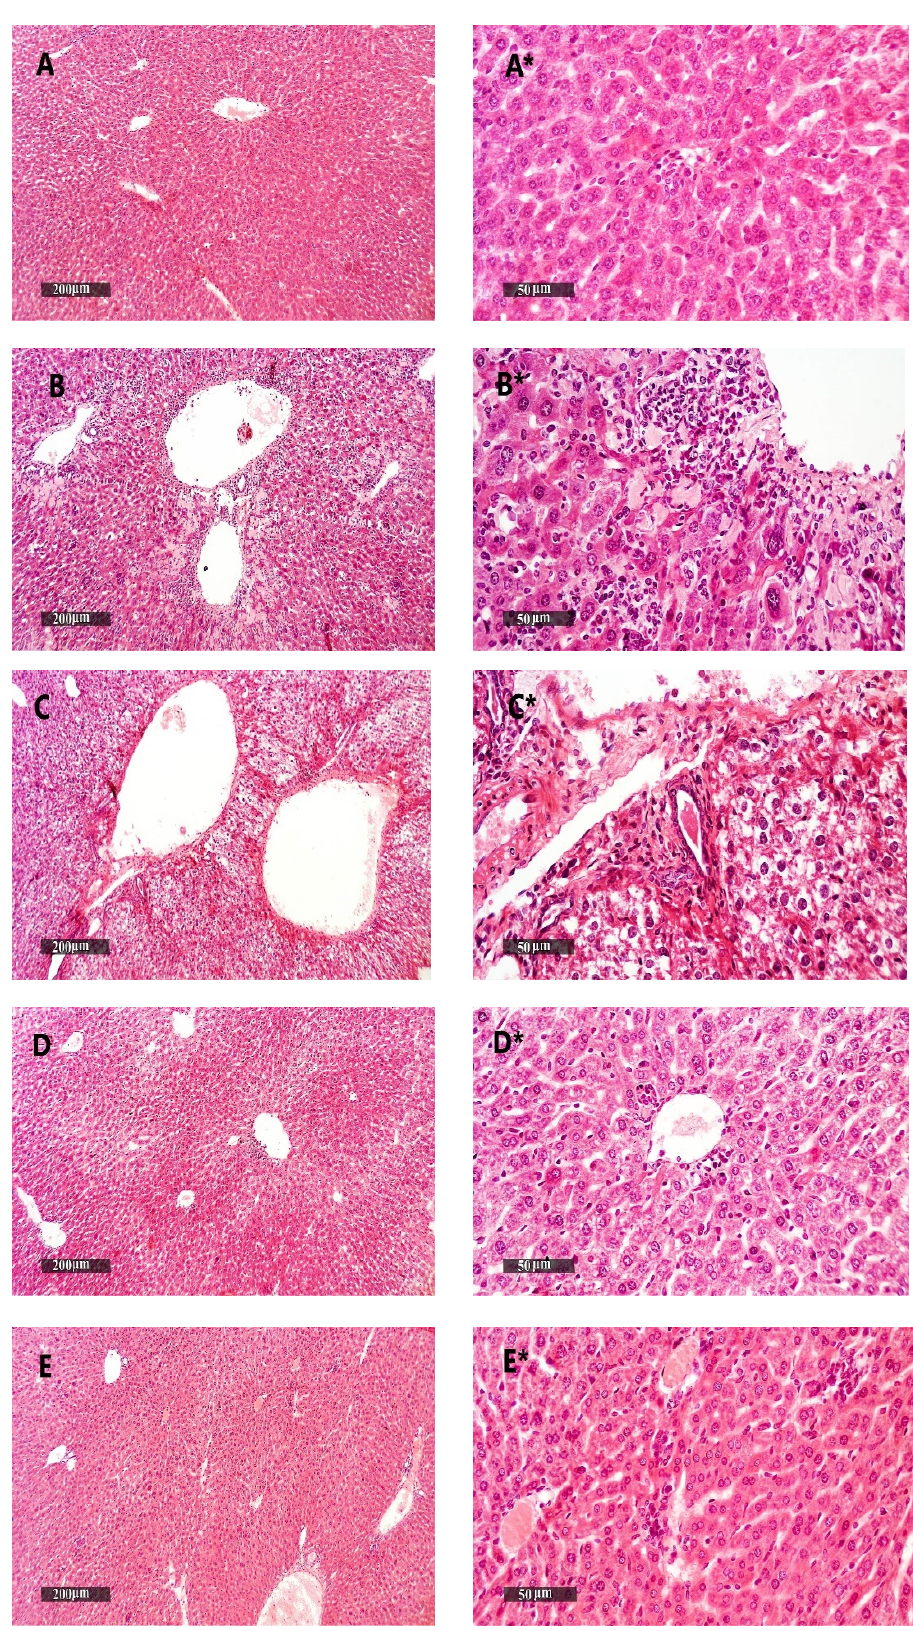
Figure 12. Liver samples stained with H&E. ( A , A* ) Liver samples from the vehicle + empty gel group Figure 11. Liver samples stained with H&E. ( A , A* ) Liver samples from the vehicle+empty gel group show the normal morphological structure of hepatic parenchyma. ( B , B* ) DMBA + empty gel show the normal morphological structure of hepatic parenchyma. ( B , B* ) DMBA+empty gel samples show mild hepatocellular degenerative changes in the pericentral, as well as periportal, regions,